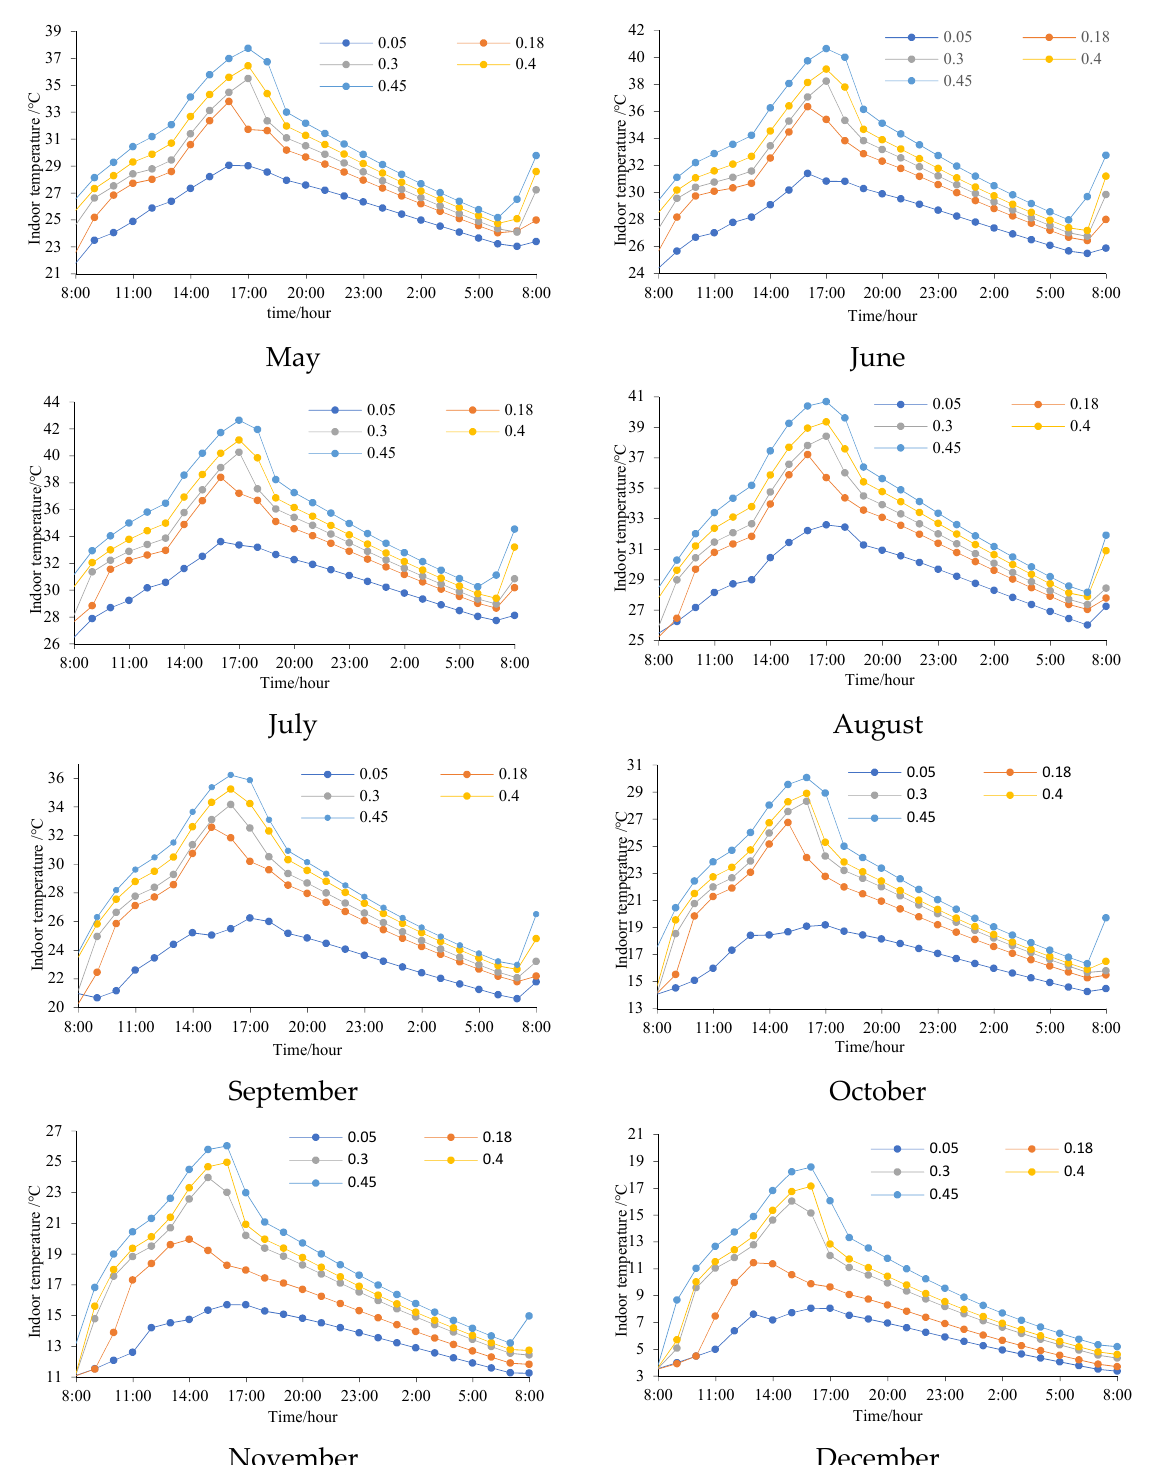
Figure 4. Daily variations of indoor temperature under 5 SVF conditions over 12 months.